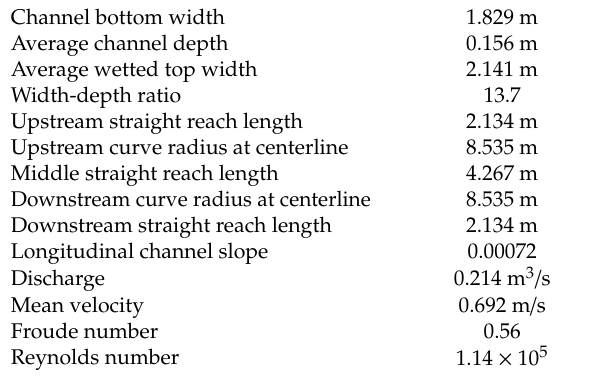
Table 2. Channel dimensions and hydraulic properties of the physical model reported by Yen [58].